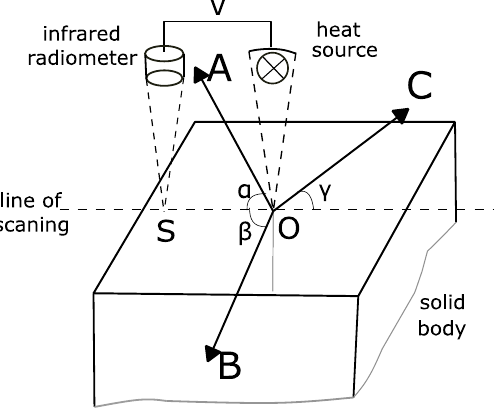
Figure 7. Principle of optical scanning method [66]. V: velocity of scanning; O: area of the heat spot; S: detection area of the radiometer; A, B, C: main axes of thermal conductivity with angles α , β , γ to the line of scanning, respectively.